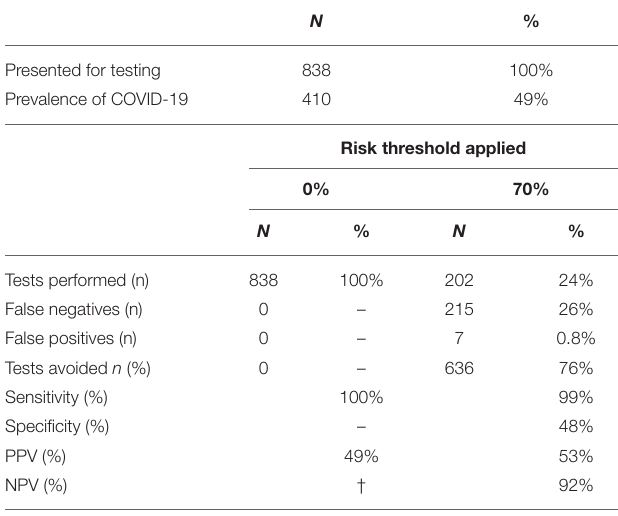
TABLE 2 | Model performance characteristics for the holdout